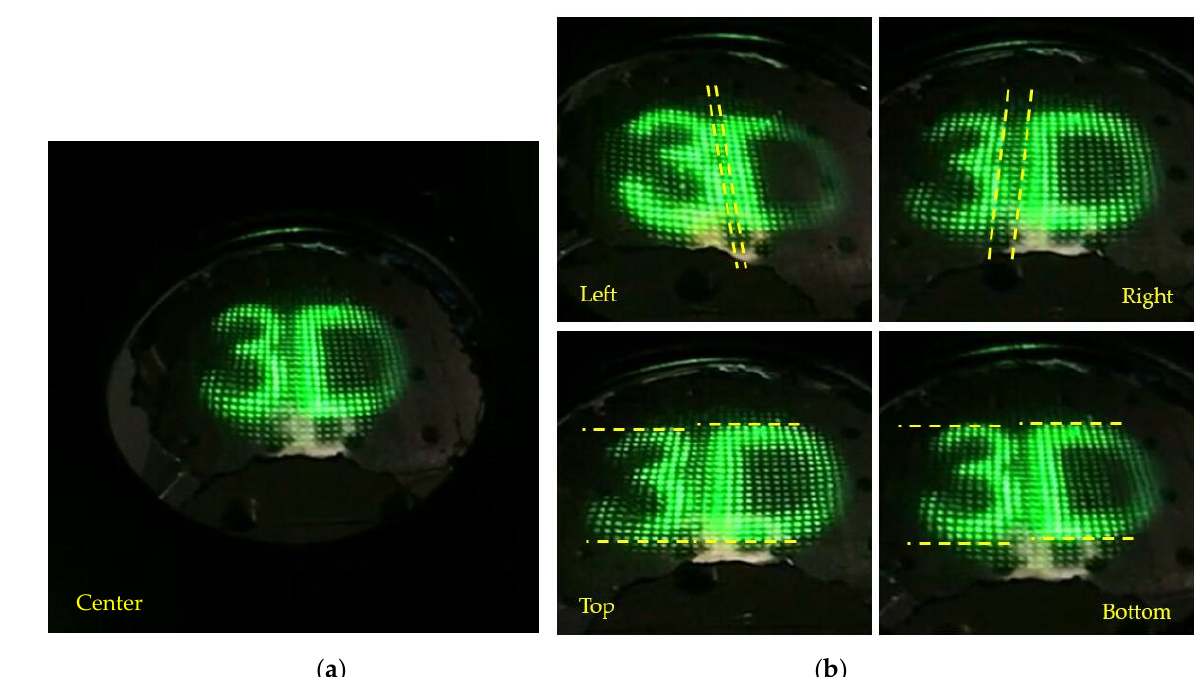
Figure 10. Experimental results of aerial projection 3D display based on lens-array HOE and parabolic mirrors ( a ) in the center and ( b ) in the left, right, top, and bottom (see Visualization 1).